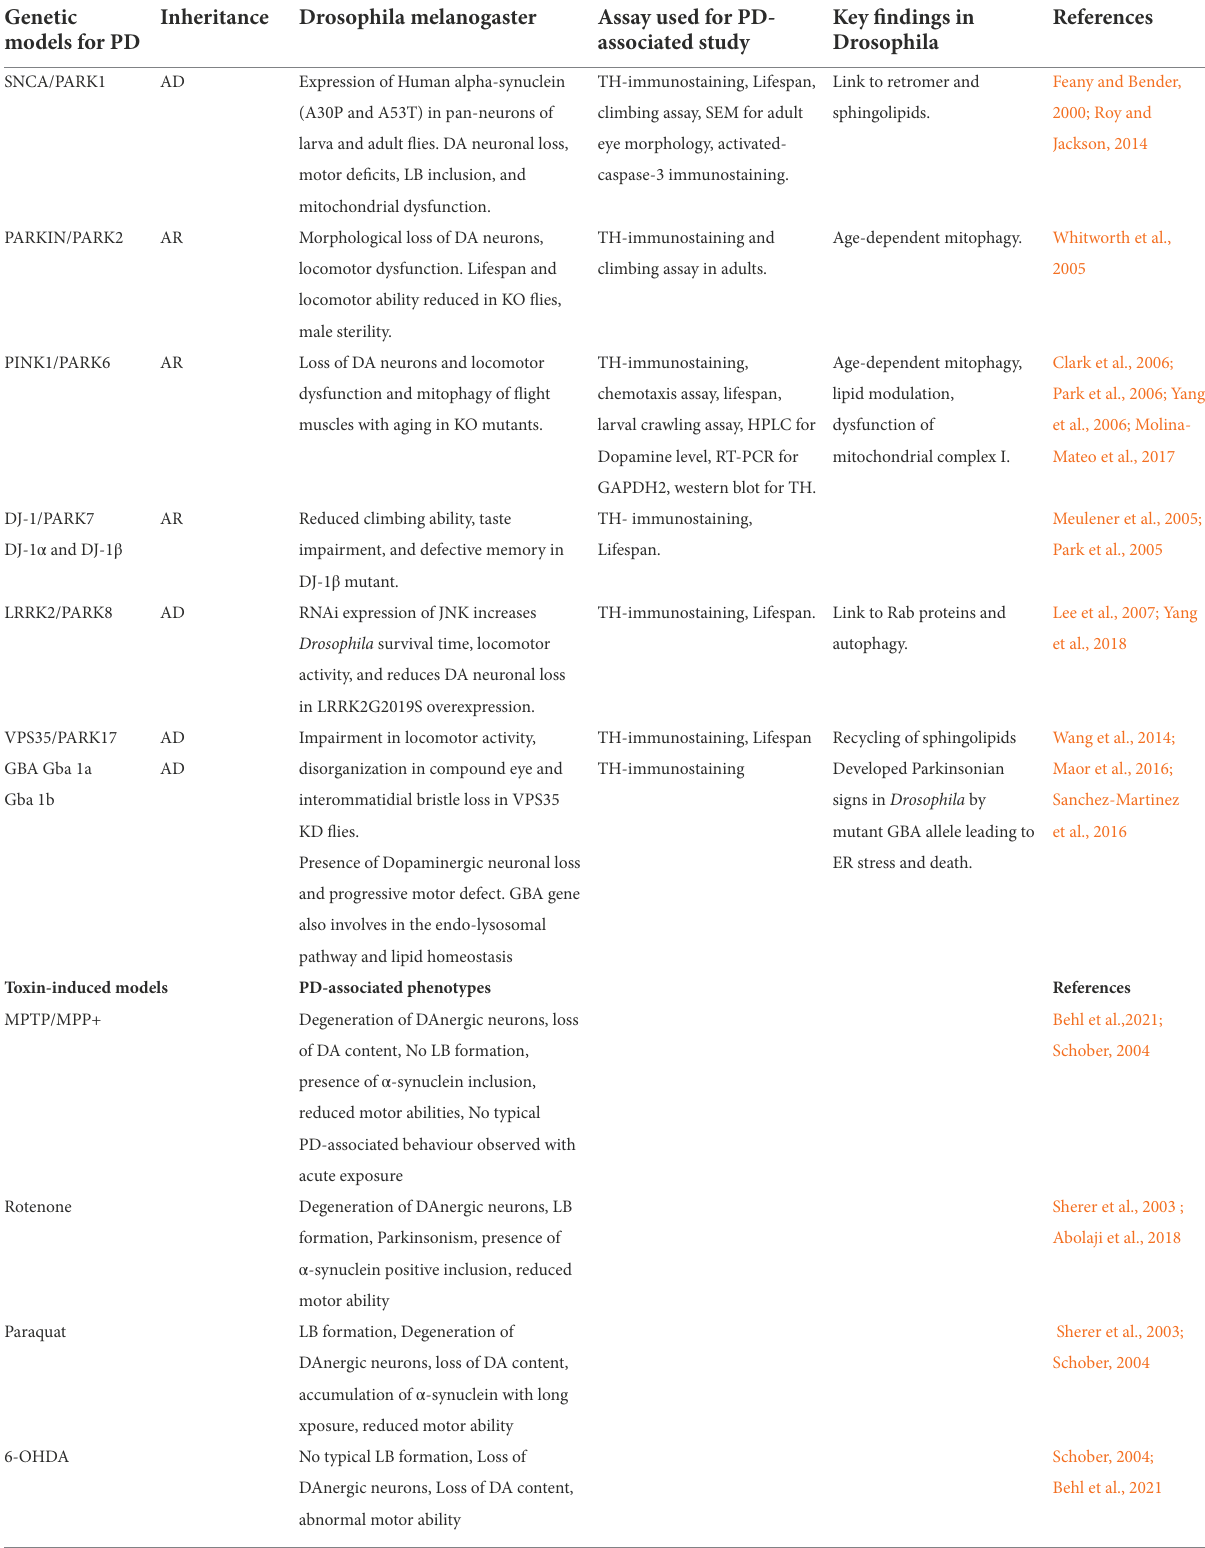
TABLE 1 List of Parkinson’s diseases associated genes and their phenotypic expression in Drosophila